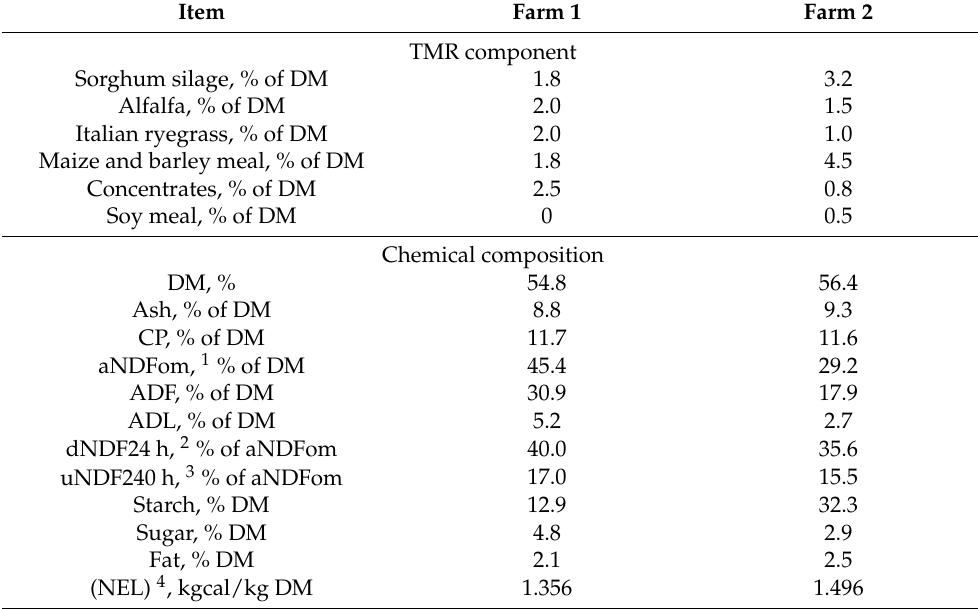
Table 1. Components of the diet and chemical composition of TMRs.